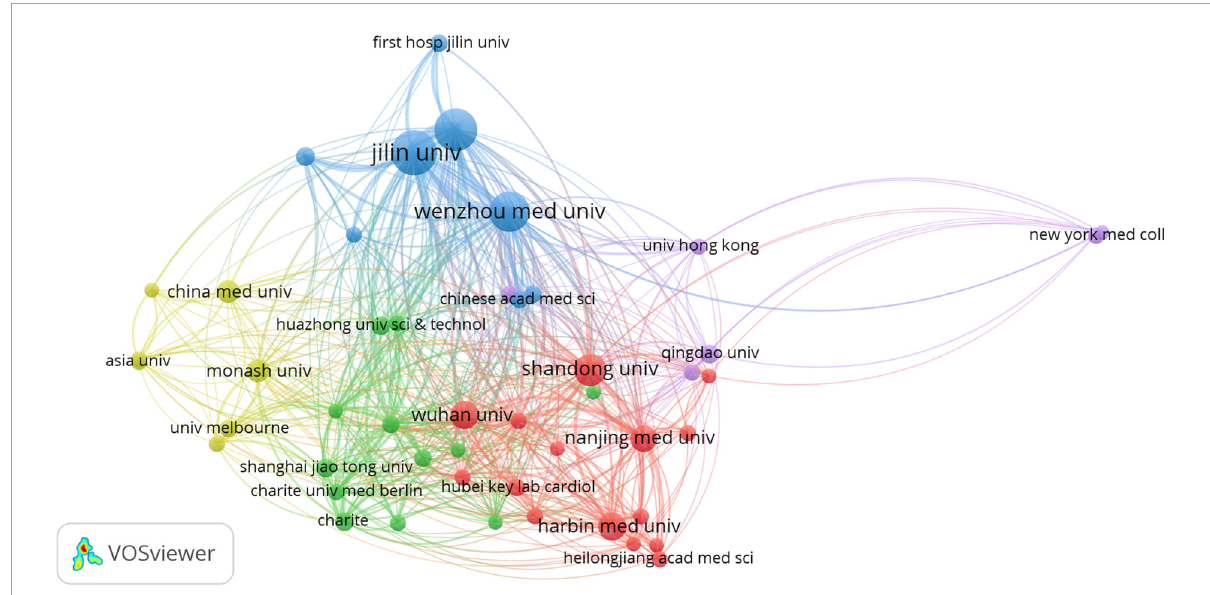
FIGURE3 Network map of co-author analysis of organizations. The method was Linlog/modularity, weight was citations, and scores were the average published year. The analysis method was Linlog/modularity in VOSviewer, the weight was an occurrence, and scores were the average published